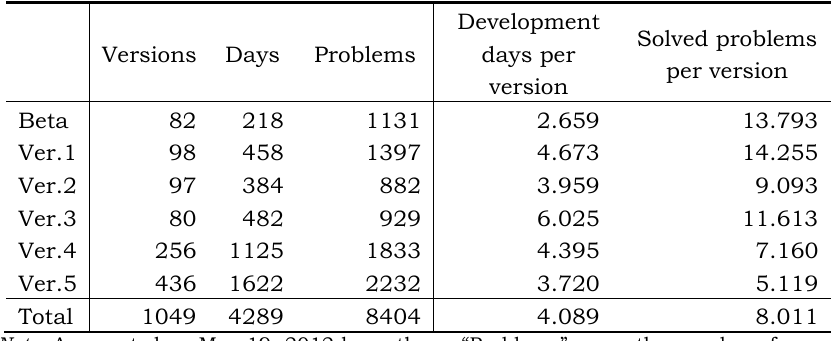
Table 2. The version up history of “Hidemaru